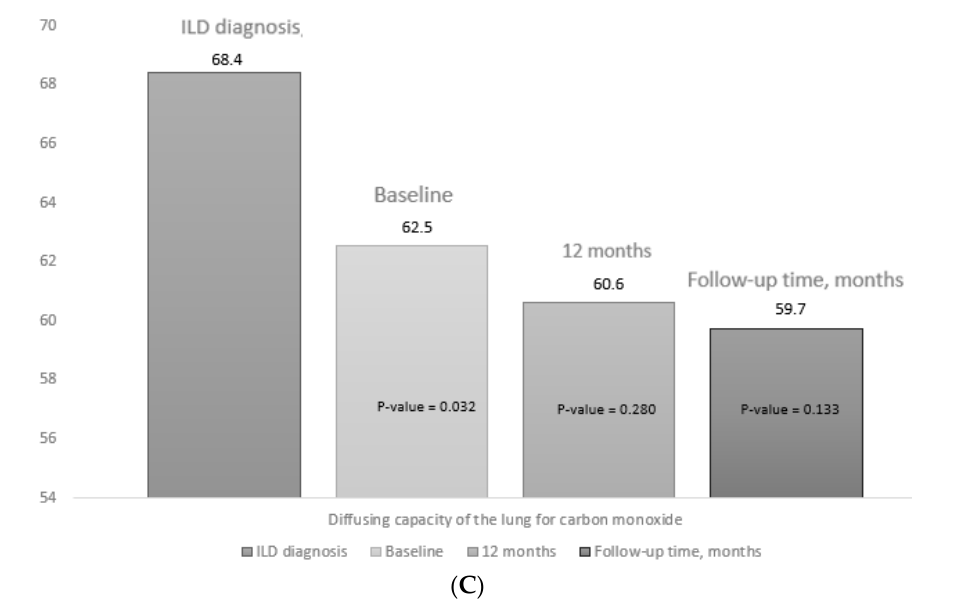
Figure 3. Progress of pulmonary function tests. Figure 3 shows the data for the pulmonary function tests at diagnosis of ILD, at the baseline visit (V0), at 12 months (V12), and at the final visit (FV): ( A ) forced vital capacity; ( B ) forced expiratory volume in the first second, ( C ) diffusing capacity of the lung for carbon monoxide. The p value for baseline (V0) is the result of comparing values between V0 and the date of diagnosis of ILD. The p value for 12 months (V12) and at the end of follow-up (FV) is the result of the comparison between V12 and FV and baseline (V0). The median (IQR) follow-up time was 27.3 (12.2–42.8) months.